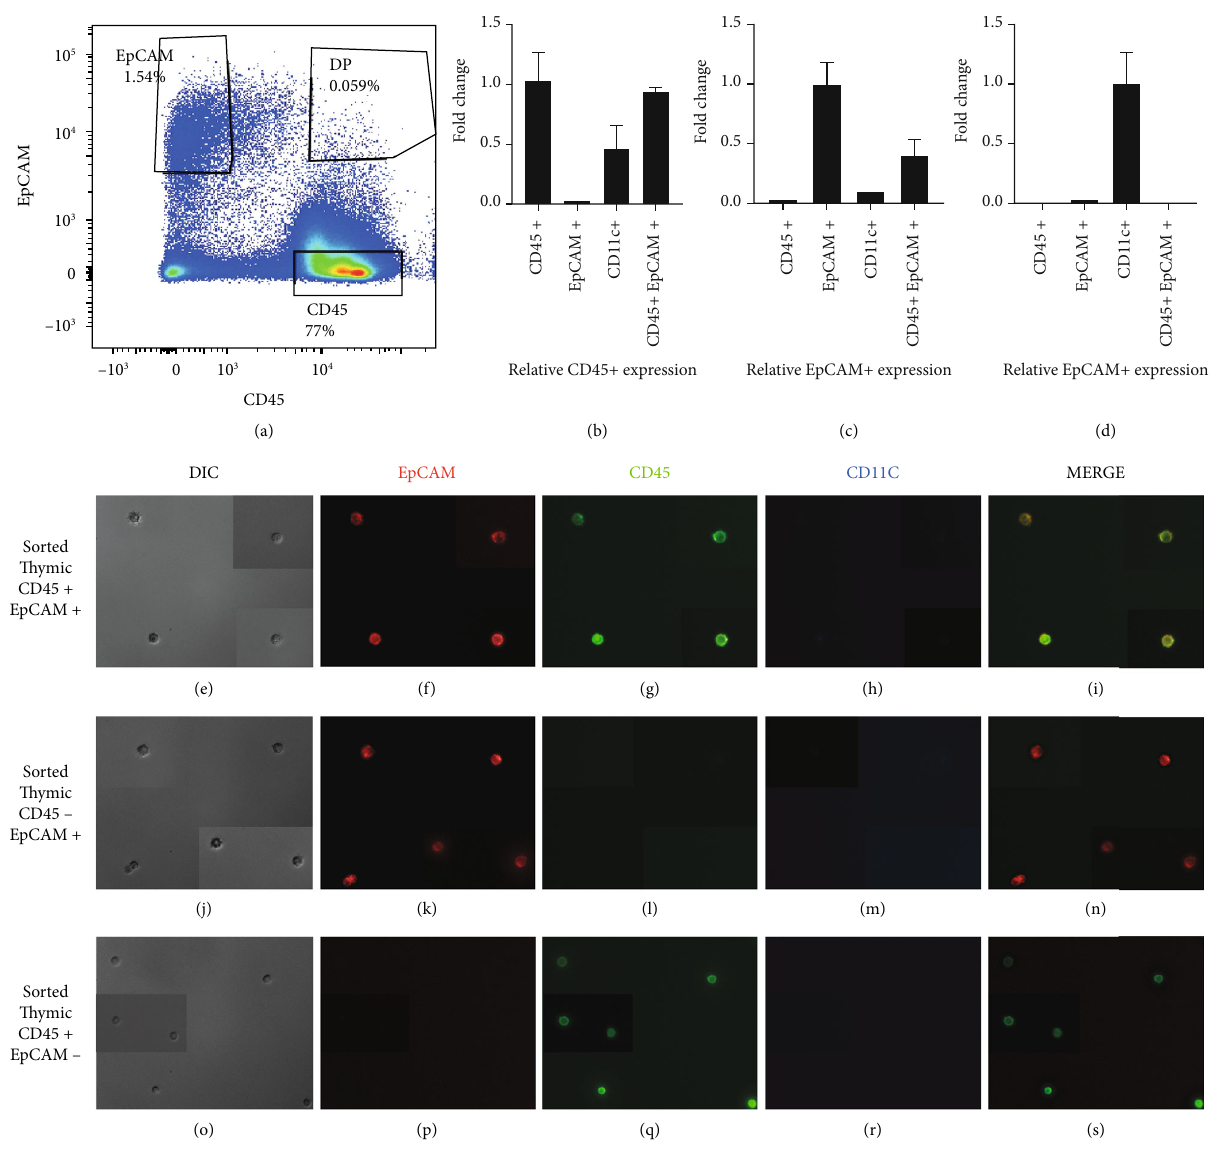
Figure 2: Single sorted thymic CD45+ EpCAM+ cells express both the CD45 and EpCAM surface proteins as well as mRNA for both genes. CD45+ EpCAM+ cells were sorted to high purity and analyzed for CD45 and EpCAM expression using immuno fl uorescence microscopy and qRT-PCR. CD45+ EpCAM- and CD45- EpCAM+ cells were sorted as controls. (a) FACS analysis representation of the gating strategy used for the sorting of the EpCAM+ CD45-, EpCAM+ CD45+, and EpCAM-CD45+ populations subsequently analyzed by qPCR and histology. (b) Shows the relative CD45 mRNA expression level in the thymus-derived CD45+ EpCAM+ cells compared to the CD45+ EpCAM- and CD45- EpCAM+ control populations. (c) Shows the relative EpCAM mRNA expression level in the thymus- derived CD45+ EpCAM+ cells compared to the CD45+ EpCAM- and CD45- EpCAM+ control populations. (d) Shows the relative CD11c mRNA expression level in the thymus-derived CD45+ EpCAM+ cells compared to the lineage positive (CD11c+), CD45+ EpCAM-, and CD45- EpCAM+ control populations. (e – i) DIC image, EpCAM staining (red), and CD45 staining (green); CD11b, CD11c, and CD19 staining (blue); and merged (CD45 and EpCAM) images, respectively, for CD45+ EpCAM+ experimental population; (j – n) DIC image, EpCAM staining (red), and CD45 staining (green); CD11b, CD11c, and CD19 staining (blue); and merged (CD45 and EpCAM) image, respectively, for CD45- EpCAM+ control population; (o – s) DIC image, EpCAM staining (red), and CD45 staining (green); CD11b, CD11c, and CD19 staining (blue); and merged (CD45 and EpCAM) image, respectively, for CD45+ EpCAM- control population. Insets added to each panel show additional cells from other images of the same experiment. A minimum of three replicates of all experiments were